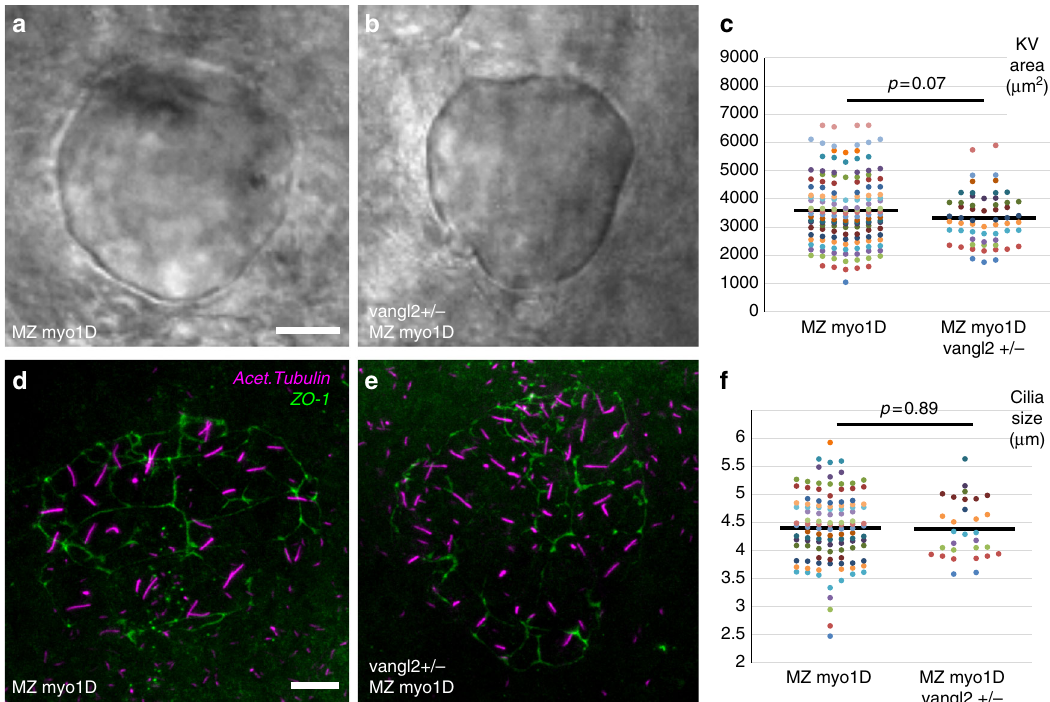
Fig. 5 KV area and cilia size are similar in MZ myo1D and MZ myo1D vangl2 + / − . a – c MZ myo1D ( n = 156) and MZ myo1D ; vangl2 + / − ( n = 60) animals have similar KV sizes. d – e Projection of images from confocal stacks used to quantify the length of cilia (acetylated tubulin, magenta) in the KV (ZO-1 positive cells, green) of MZ myo1D mutants ( d ), or MZ myo1D ; vangl2 + / − embryos ( e ). f MZ myo1D ( n = 117 embryos/4939 cilia) and MZ myo1D ; vangl2 + / − ( n = 30/1653) embryos present a similar cilia size. The MZ myo1D mutant dataset displayed in f is the same that is also displayed in Fig. 3j. a , b , d , e are dorsal views of eight-somites stage KVs, anterior up. Scale bars: 20 µ m in a , b ; 10 µ m in d ,